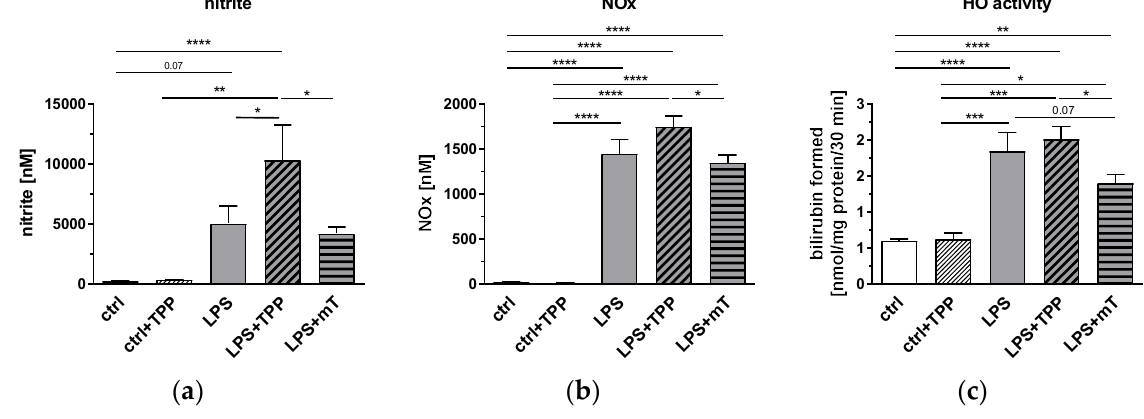
Figure 2. Effect of lipopolysaccharide (LPS, 1.75 mg/kg), methyltriphenylphosphonium chloride (TPP, 50 nmol/kg) and mitoTEMPO (mT, 50 nmol/kg) on the levels of nitric oxide (NO) derivatives ( a ), and nitrite and nitrogen oxide (NOx) in rat plasma ( b ), as well as heme oxygenase (HO) activity in liver tissue ( c ). MitoTEMPO decreases the activity of the tested metabolites ( a – c ) while TPP increases the mean values of NO derivatives ( a ) and NOx ( b ) in the blood. One-way analysis of variance (ANOVA), Fisher’s least significant difference (LSD), n = 3–8, mean ± SEM, * p < 0.05, ** p < 0.01, *** p < 0.001, **** p < 0.0001.